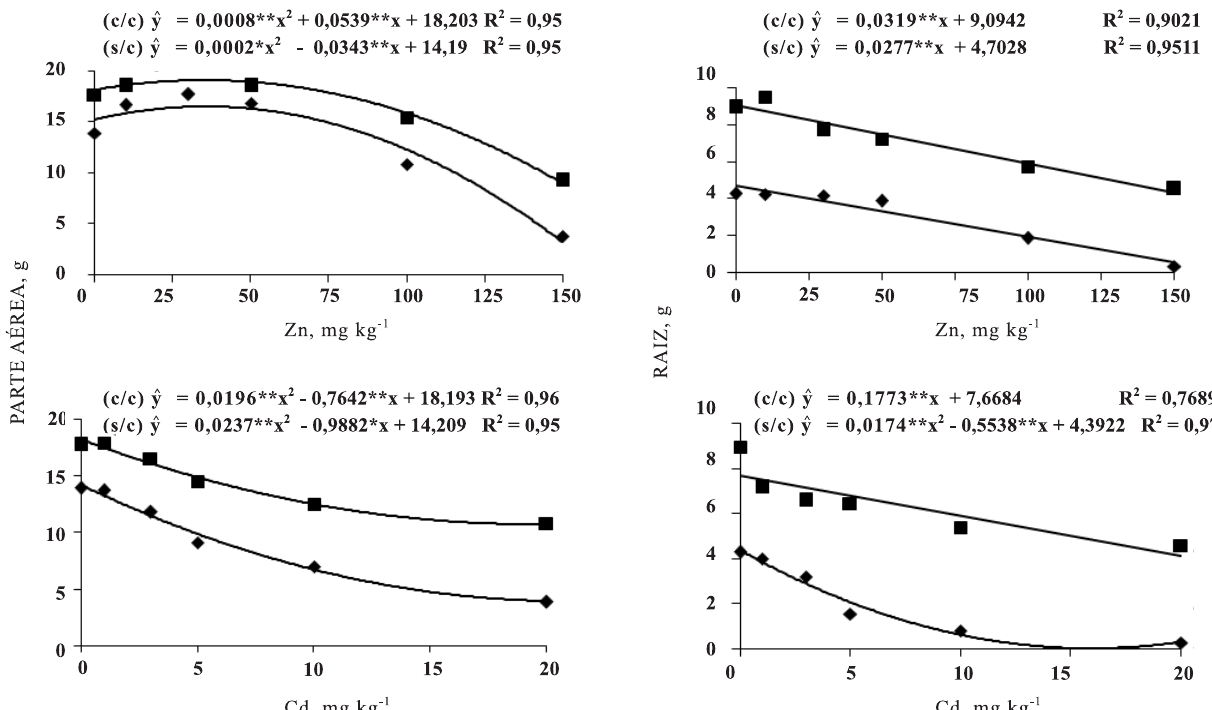
Figura 1. Produção de matéria seca da parte aérea e raiz de milho submetido a doses crescentes e Cd e Zn no solo com ( ) e sem ( )